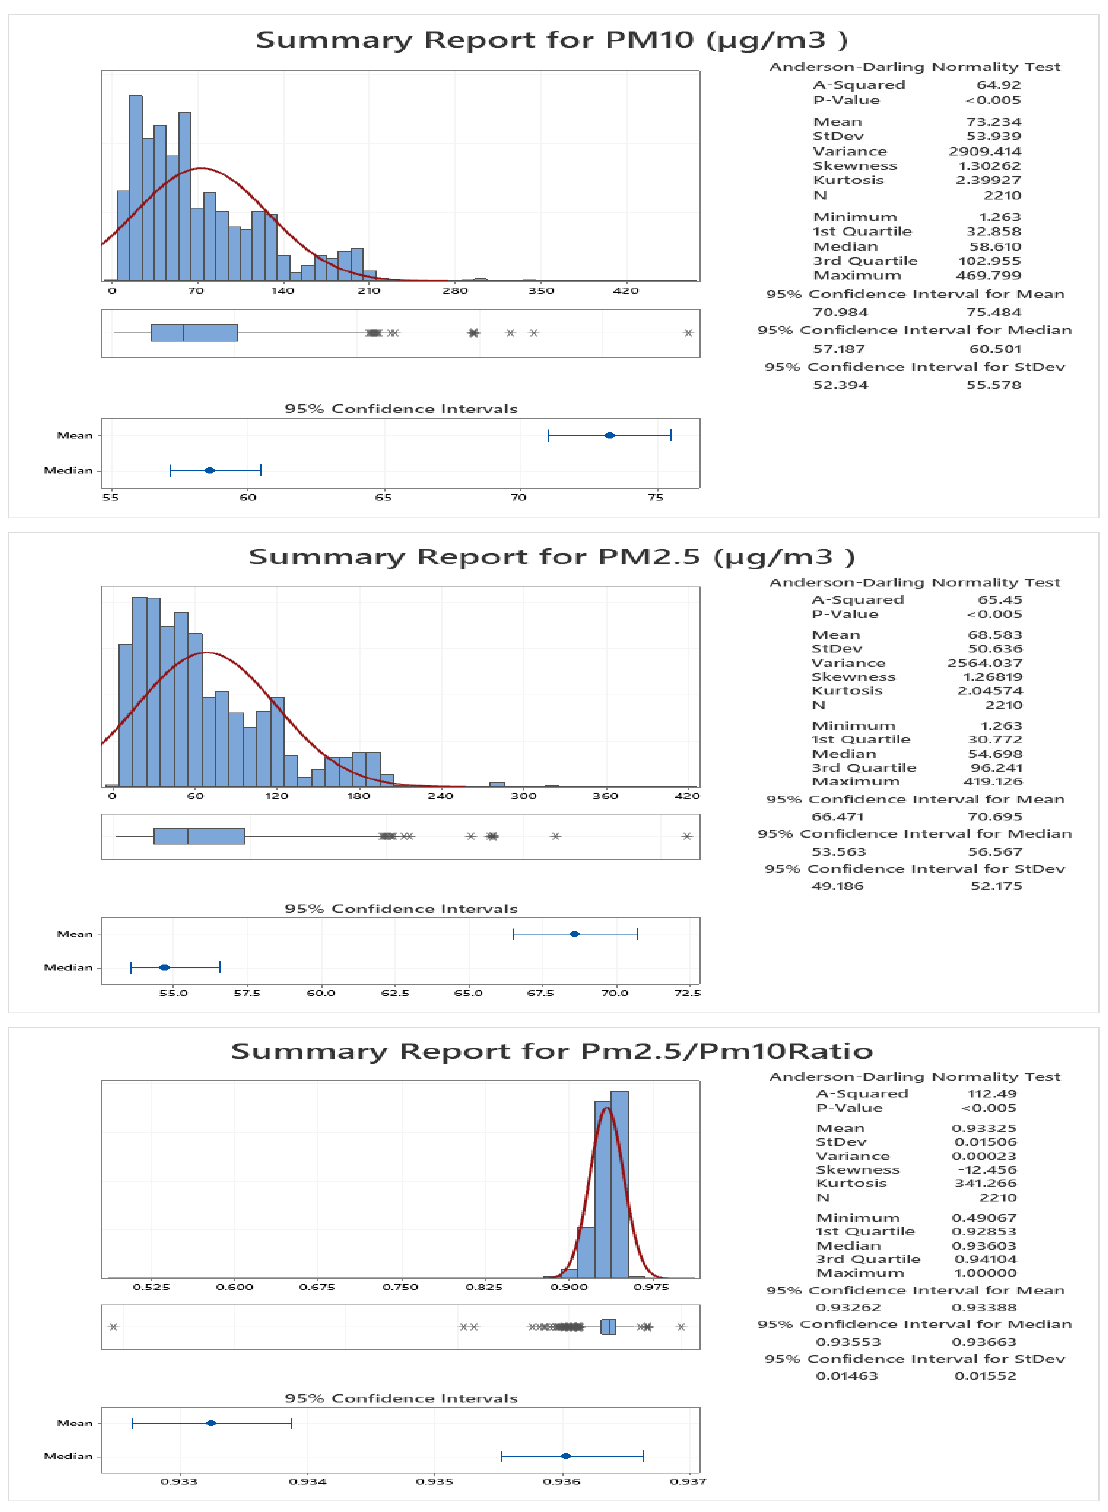
Figure 1. The Summary Report of PM 10 , PM 2.5 , and Their